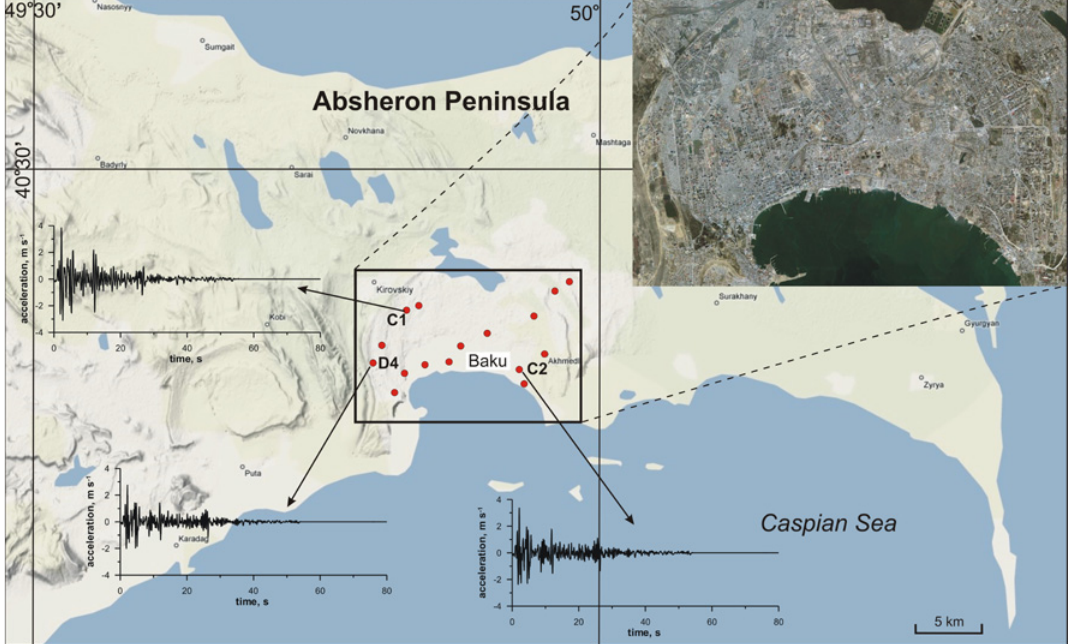
Fig. 2. Topography of the Absheron peninsula and the location of the studied region (solid rectangular). The dots indicate the sites of drilled boreholes; the geological and geophysical data from these boreholes were used in this study. The modelled accelerograms are presented for three typical subsurface models C1, C2, and D4 (see Table 2 for the subsurface model description). Satellite image of the study region (Baku city) is presented in the inset.